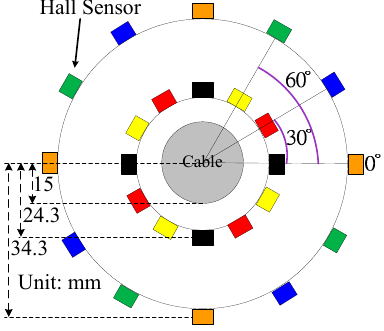
Figure 3. Design of double-layer sensing structure.